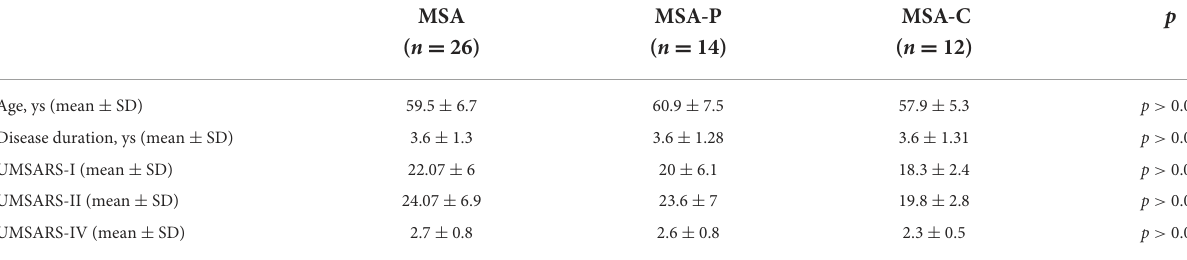
TABLE 1 Demographic and clinical findings of enrolled patients at baseline.